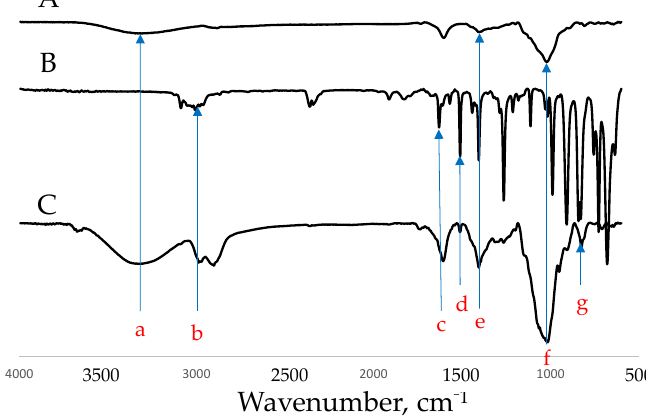
Figure 3. Stacked FT IR spectra of GG (A), 4-VBC (B), and VBzGG-3 (C).